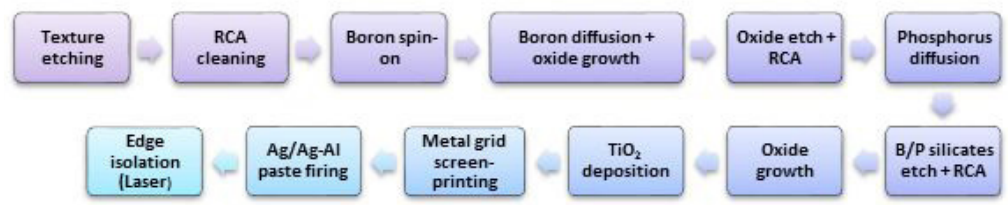
Figure 1. Fabrication process sequence used to produce thin n + np + silicon solar